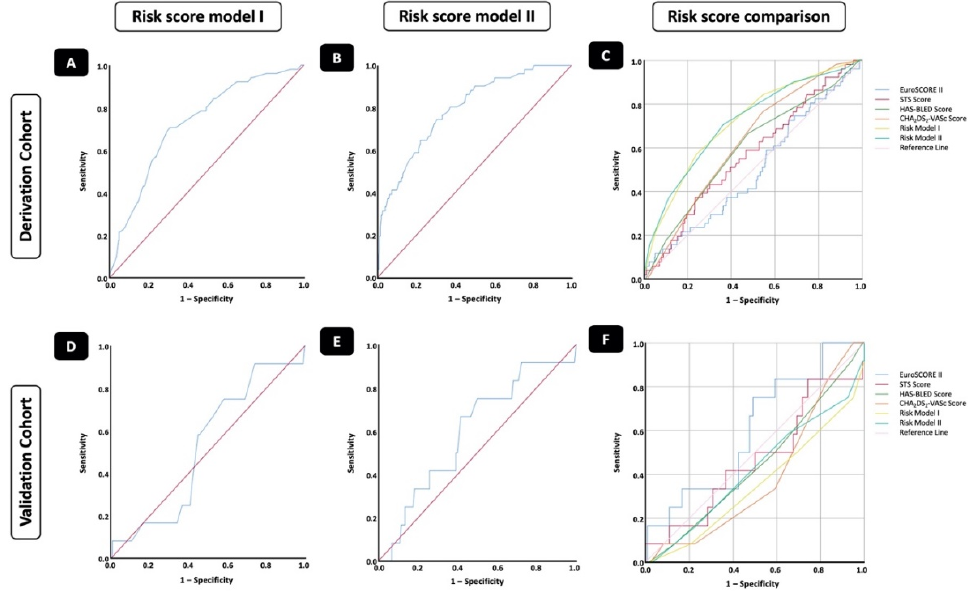
Figure 2. Risk score models I and II in comparison with established risk scores in the derivation and validation cohorts. ( A ) ROC analysis for risk score model I in the derivation cohort. AUC = 0.73 (95% CI 0.66–0.80), p < 0.001. Sensitivity = 70.6%; specificity = 69.0%; PPV = 19.5%; NPV = 95.7%. ( B ) ROC analysis for risk score model II in the derivation cohort. AUC = 0.79 (95% CI 0.73–0.86), p <